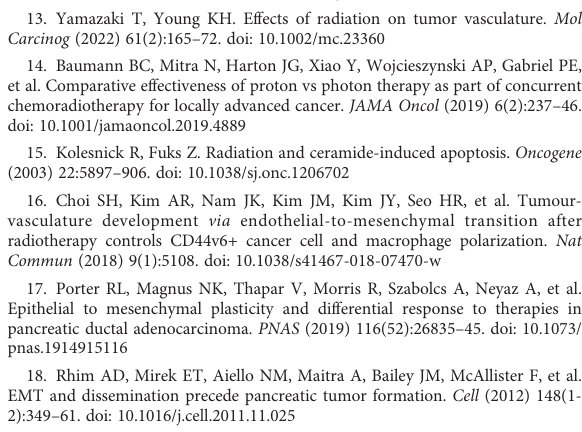
SUPPLEMENTARY FIGURE 1 (A) Distribution of endothelial nuclei across 37 treated and untreated PDAC samples. (B) Estimated stability (blue, left y axis) and error (red, right y axis) in the cNMF solution learned with different numbers of components/programs ( k , x axis) for endothelial cells. (C) Gene set enrichment analyses (-log 10 FDR) for State Program 1 (ribosomal; left) and State Program 2 (cycling; right). (D) Lineage program annotations based on similarity to prior endothelial cell signatures from Schupp et al